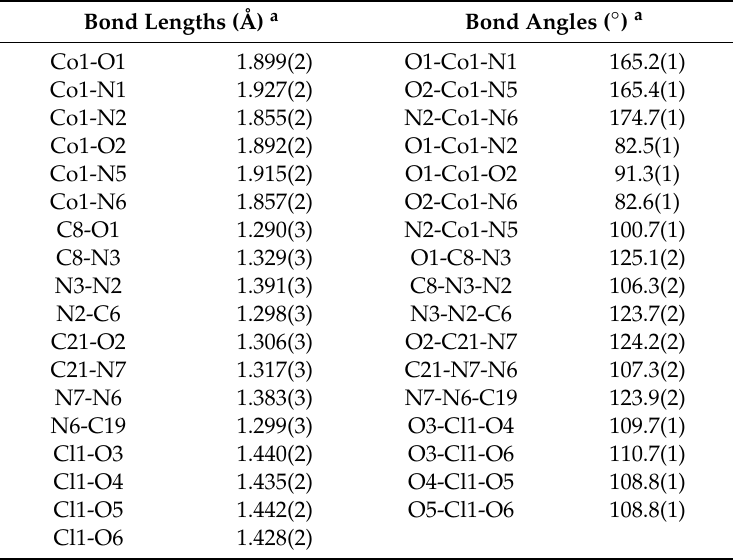
Table 3. Selected bond lengths (Å) and angles for complex 4